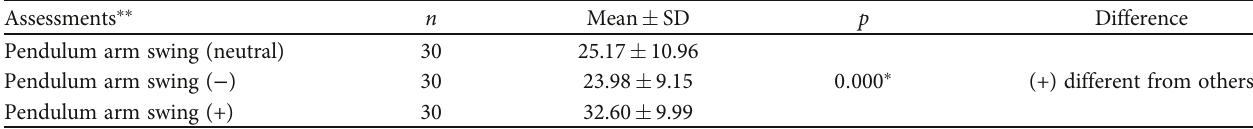
T ABLE 1: Examination of the differences between arm swing measurements.